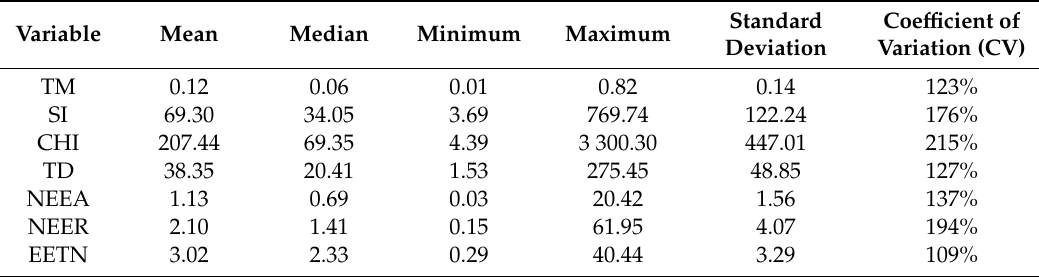
Table 3. Descriptive statistics of